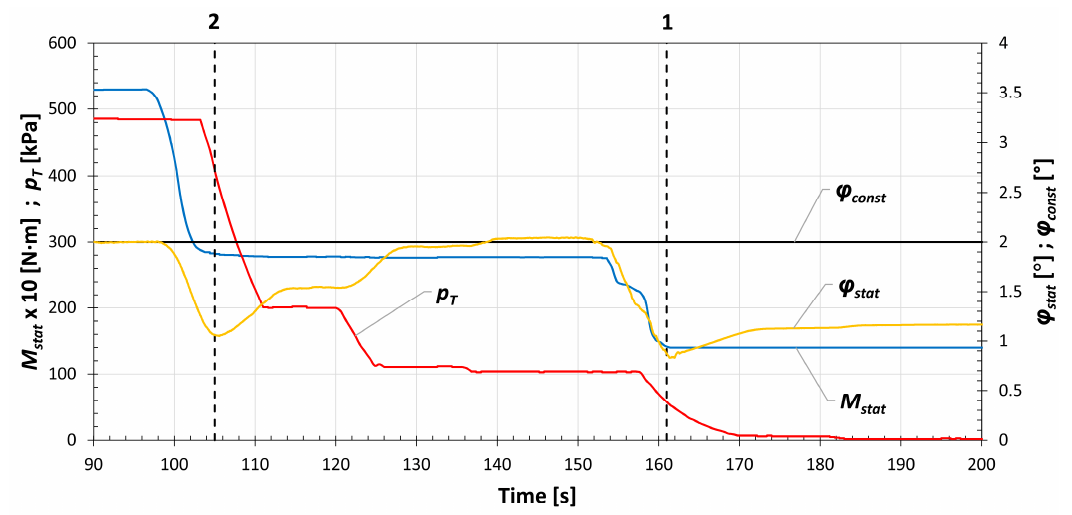
Figure 10. Control process by unloading the mechanical